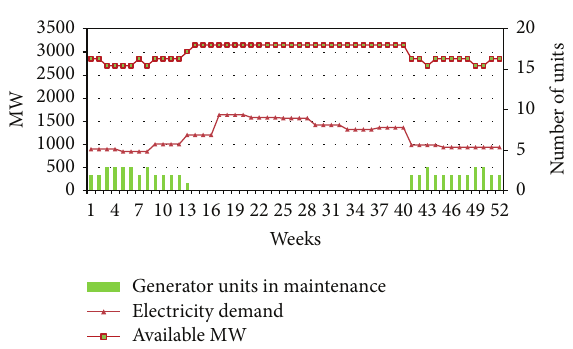
Figure 14: Generator unit system output loads and gross reserves for 21 units with 20 percent increase in